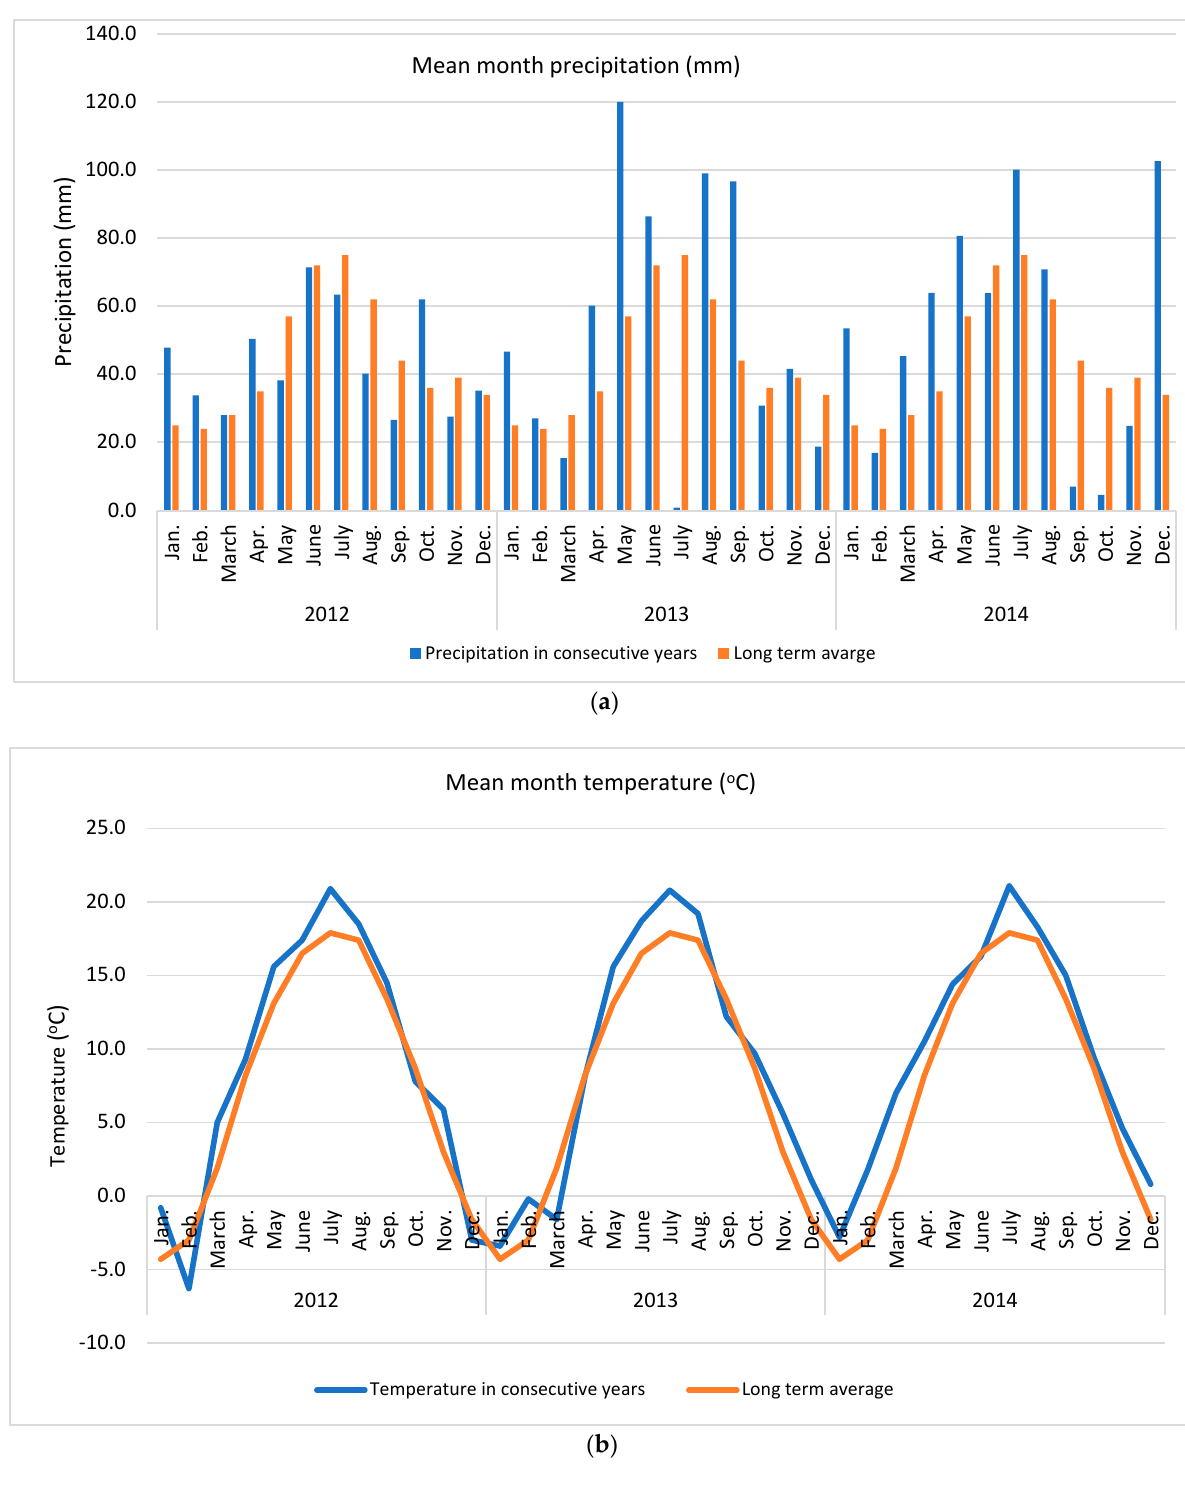
Figure 1. Weather conditions accompanying the study ( a ) mean month precipitation and ( b ) mean month temperature. 1 long term averages were calculated for the period 1982–2012.